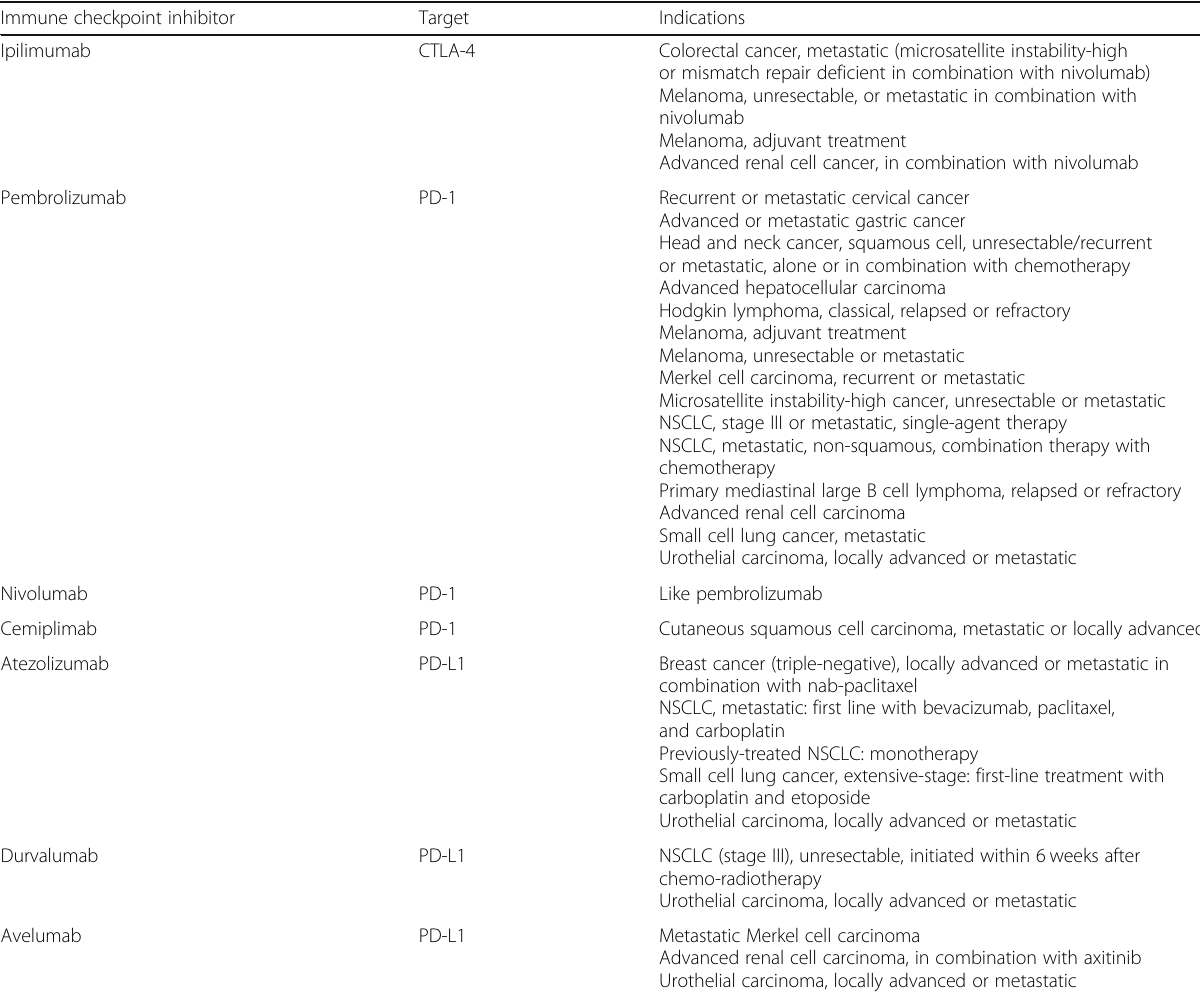
Table 1 Clinical indications of the different immune checkpoint inhibitors Immune checkpoint inhibitor